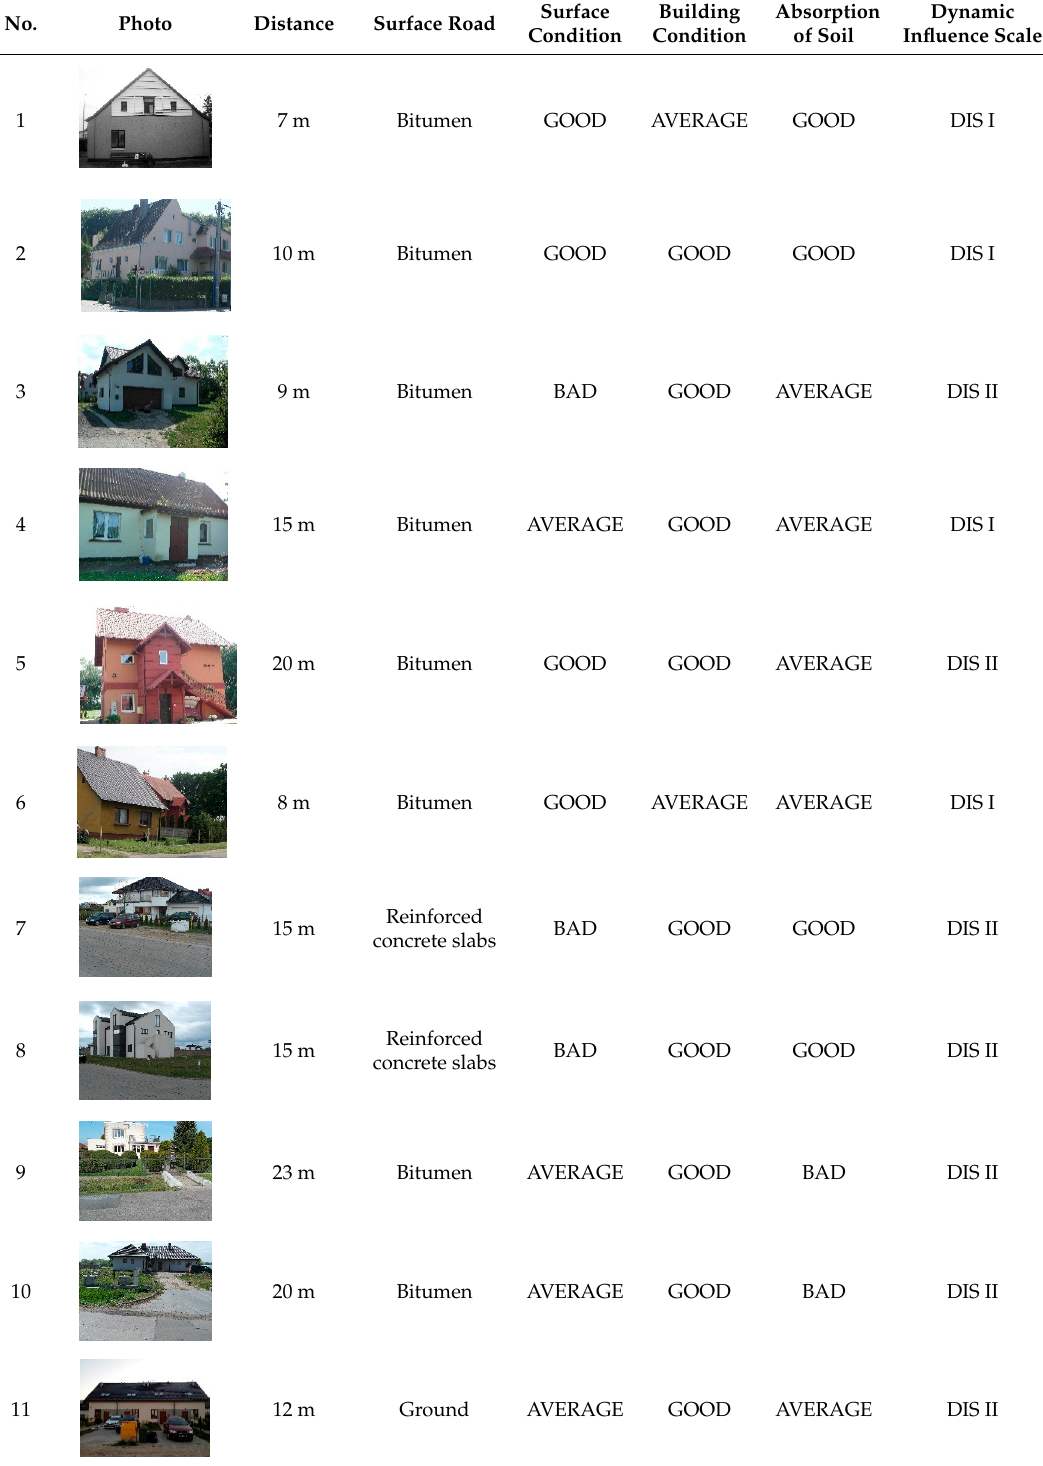
Table 1. Characteristics of the buildings studied and the result of measurements. No.